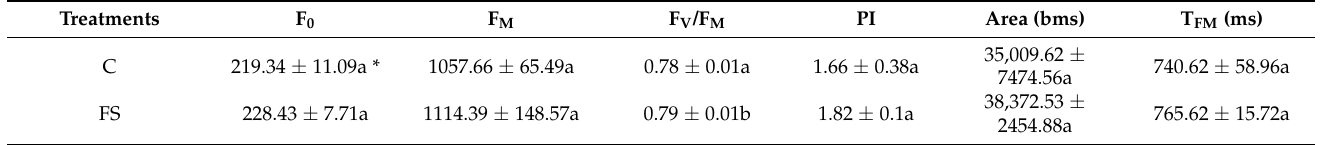
Table 4. Effect of fertilisation on the fluorescence parameters of chlorophyll “a” in leaves of